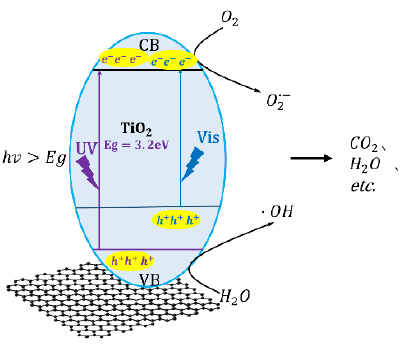
Figure 8. Photocatalytic reaction mechanism.